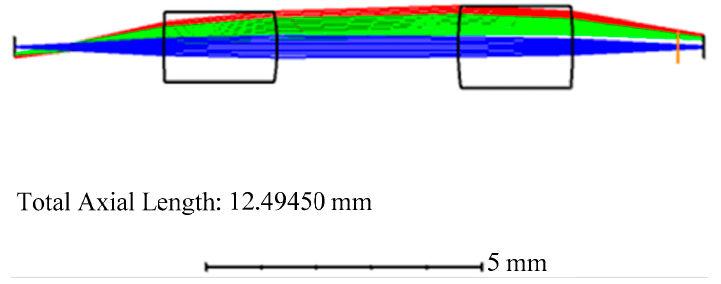
Table 2. The specification requirements.